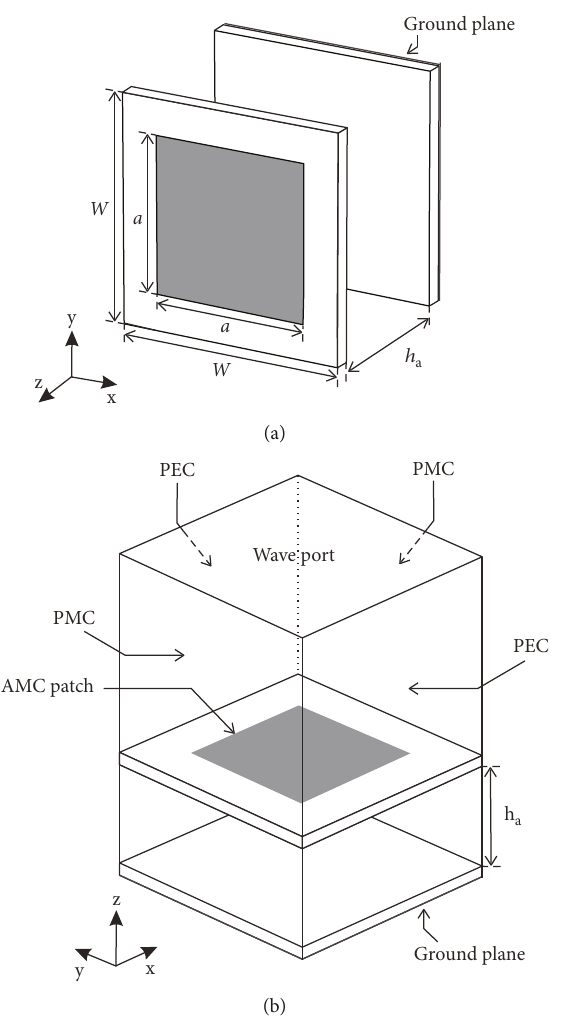
Figure 6: Geometry of the unit cell of the proposed arti fi cial magnetic conductor (AMC): (a) perspective view and (b) boundary condition of the AMC in the simulation.